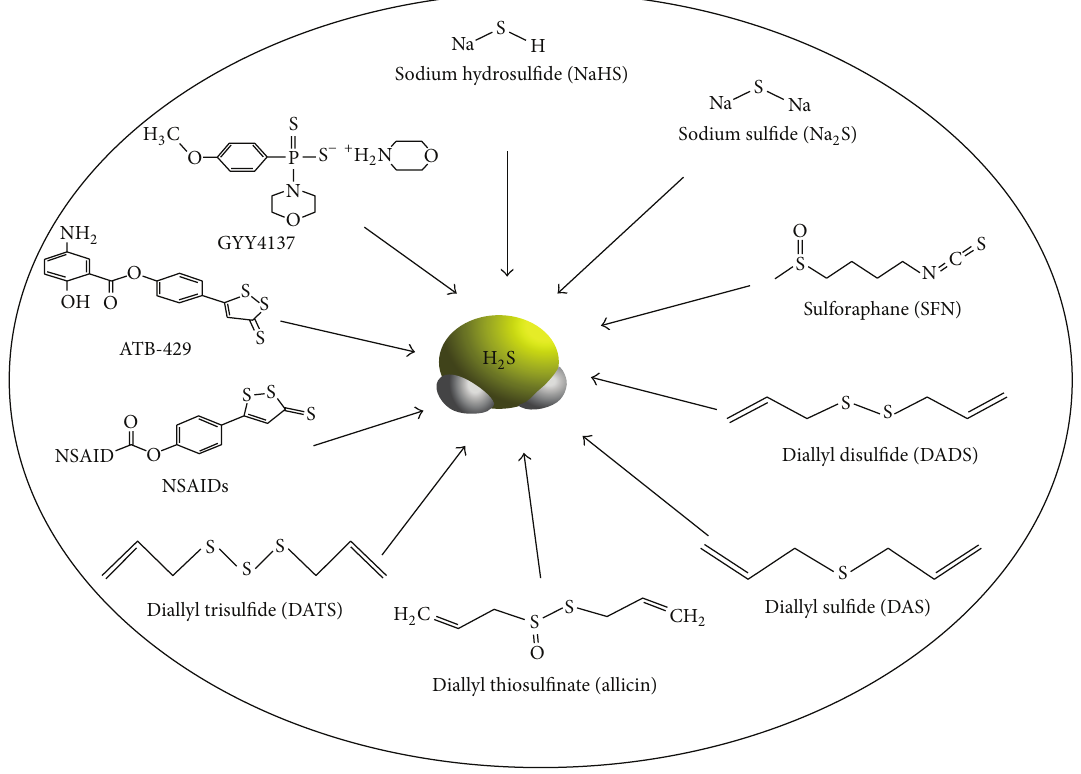
Figure 2: H 2 S-releasing